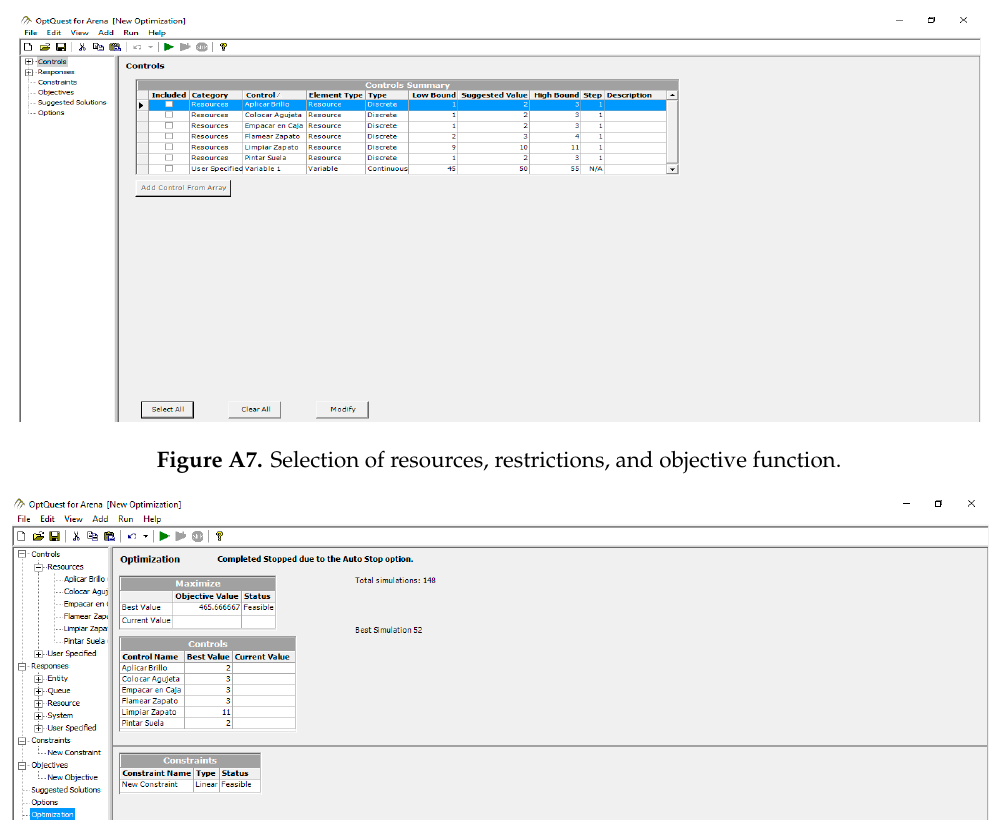
Figure A6. Final production of each activity during the process with a 7.5 h shift, Proposal.